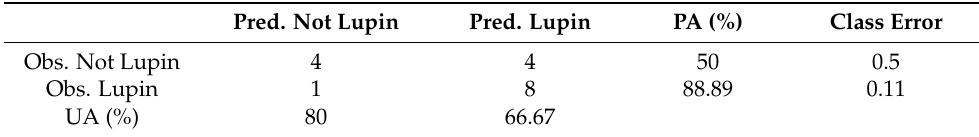
For the best model, the feature set was reduced to six Haralick texture features and one NDSI (p75_BLUGRE) calculated from the blue and green band. GBM variable importance, defined as the difference in squared error before and after a split using a particular feature, ranked all Haralick texture features before the NDSI feature (Figure 4).